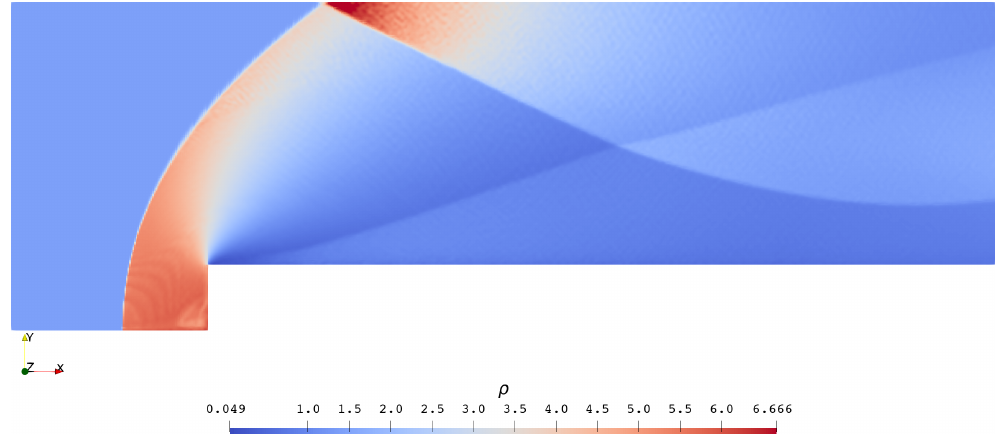
Figure 13. Third-order solution of Problem 4 at t = 1.0 on an h = 1/200 mesh.